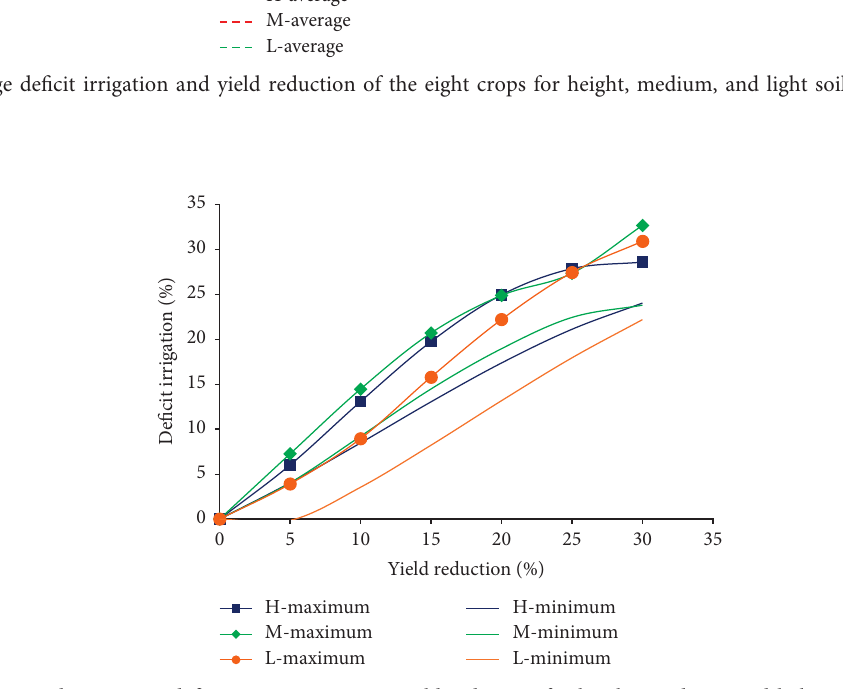
Figure 6: Maximum and minimum deficit irrigation against yield reduction for height, medium, and light soil relative to all